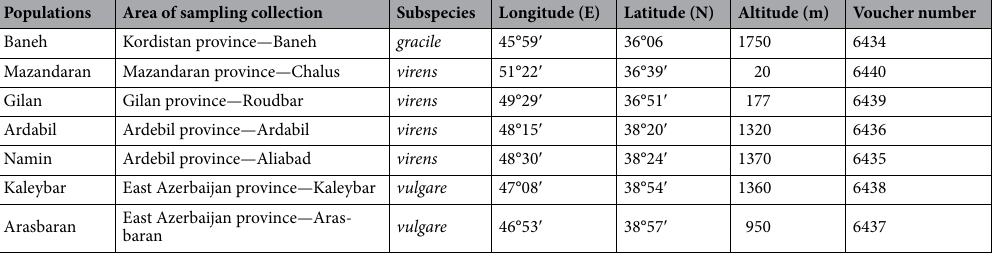
Table 1. Origin, subspecies and geographical characteristics of oregano